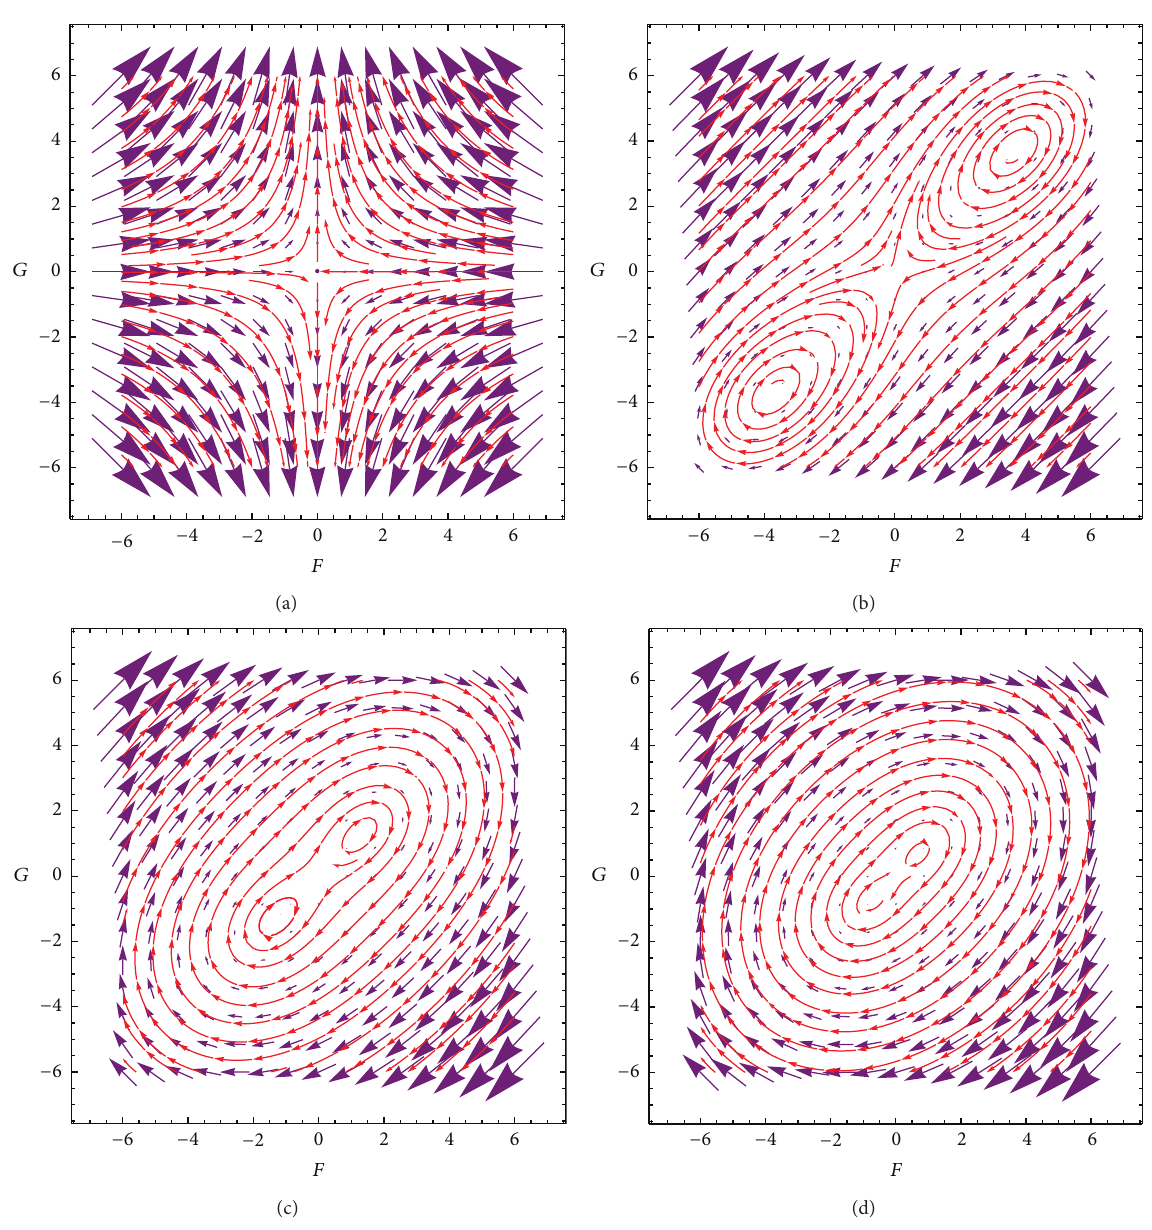
Figure 3: Vector field displays of GNDES for (a) 𝛾 = 0 ; (b) 𝛾 = 0.5 ; (c) 𝛾 = 1 ; and (d) 𝛾 = 1.5 .